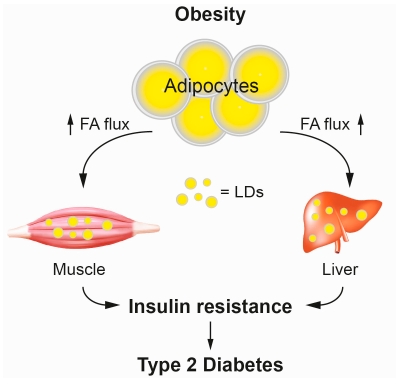
Figure 4. Schematic illustration of the relationship between obesity, ectopic accumulation of fat, insulin resistance and type 2 diabetes. Excessive metabolic energy is stored as TAGs in lipid droplets (LDs) in adipocytes. Extended exposure to high fat environment compromises storage capacity of adipocytes and leads to increased FA flux (upward arrows) and redirection of lipidstowards peripheral tissues, such as muscle and liver. Lipids exceeding the oxidative capacity of ectopic tissue are stored as TAG in LDs. Specific lipids trigger insulin resistance underlying type 2 diabetes. FA, Fatty acids.